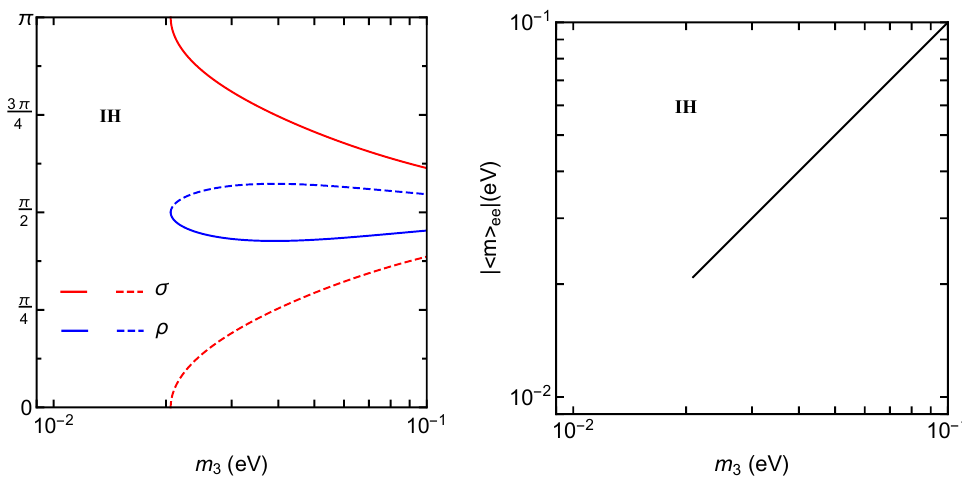
j as functions of the lightest neutrino mass m ee